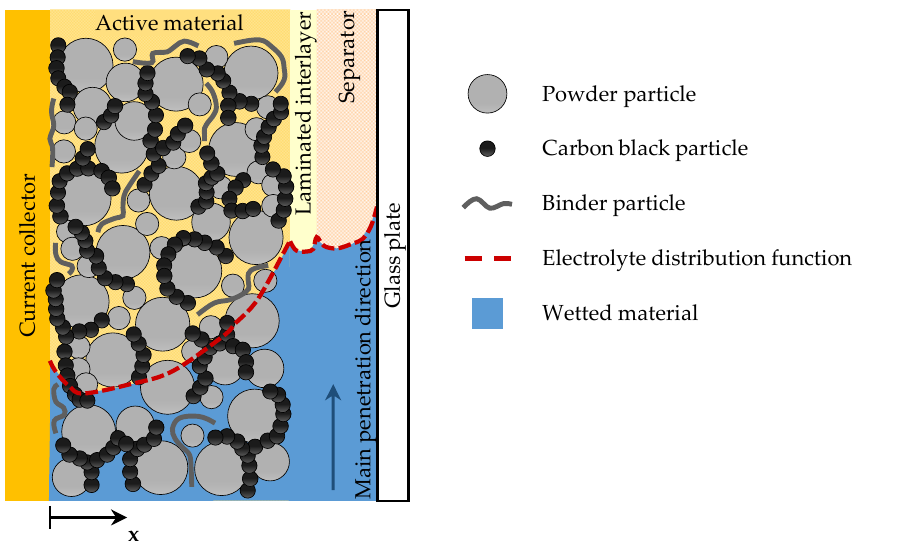
Figure 9. Schematic representation of a possible wetting profile in an electrode-separator laminate along the laminate thickness x. The assumed functional profile is imaginary and requires further investigation.